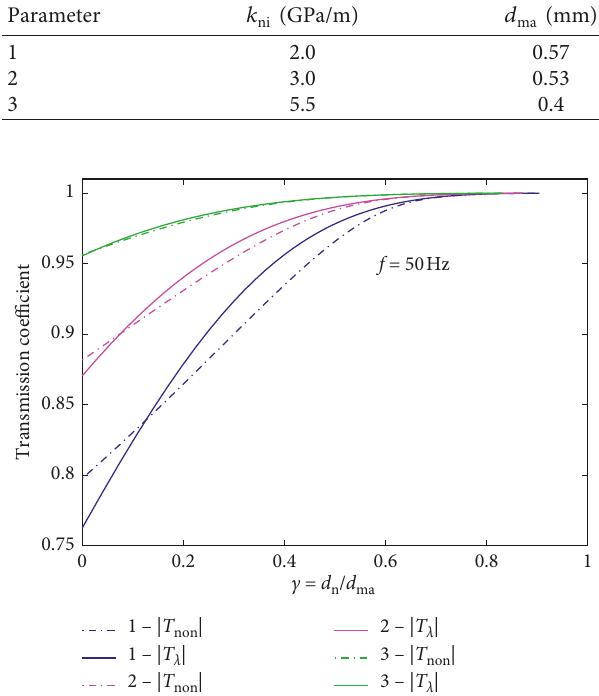
Table 3: Different values of k Parameter